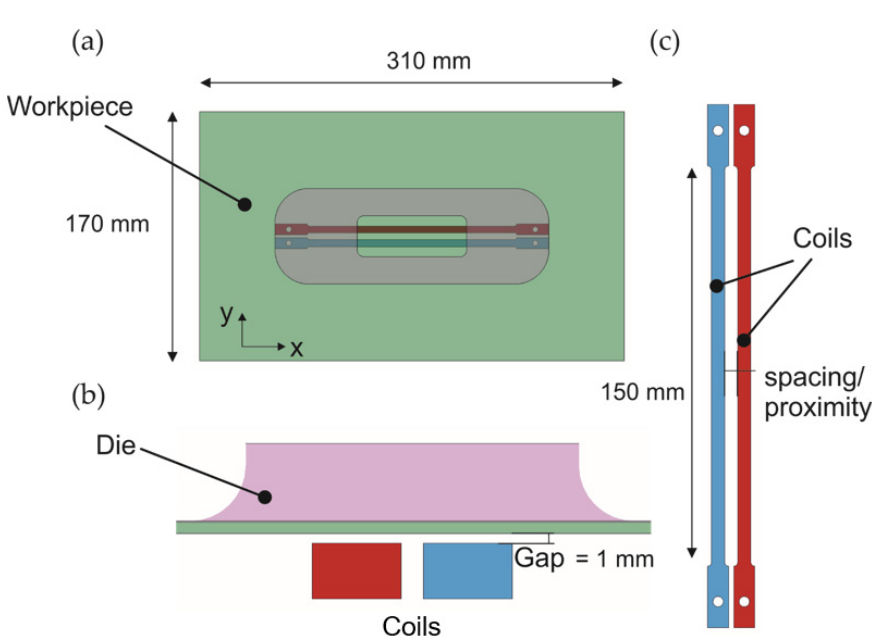
Figure 2. Numerical model in LS-DYNA. ( a ) Top view showing the dimensions of the workpiece; ( b ) front view showing the relative arrangement of the setup, ( c ) arrangement of the coils relative to one another for various values of spacing.